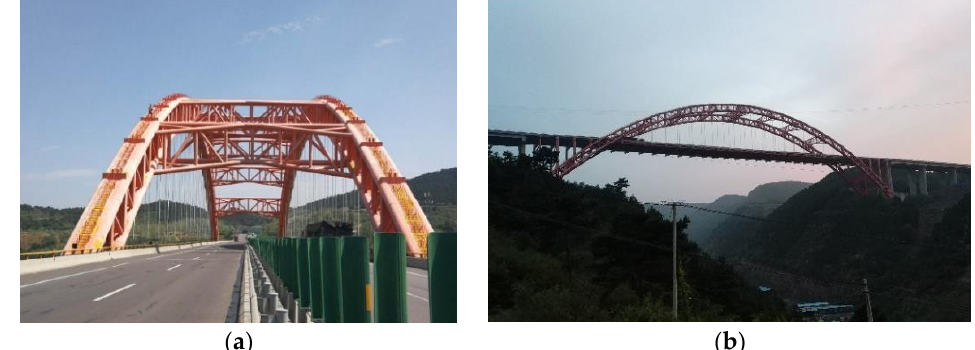
Figure 1. Beishengou concrete-filled steel tube arch bridge. ( a ) Arch bridge lane, ( b ) Overall state of arch bridge.